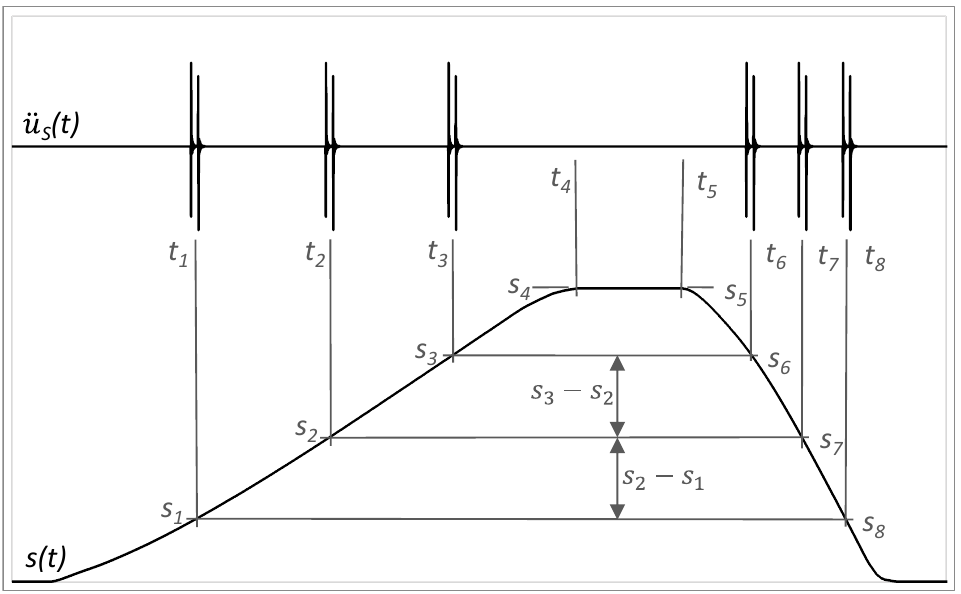
Figure 16. Acceleration amplitudes of vibrations in the context of distance by the damage of rolling elements.